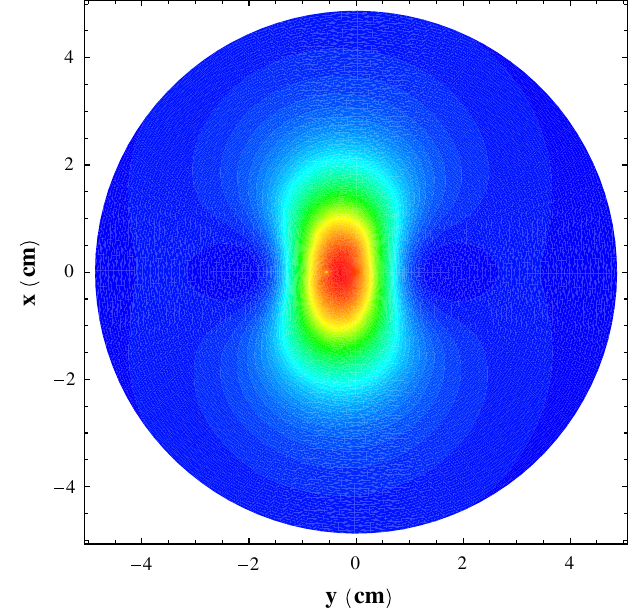
FIG. 13. (Color) Collected energy density for a Gaussian